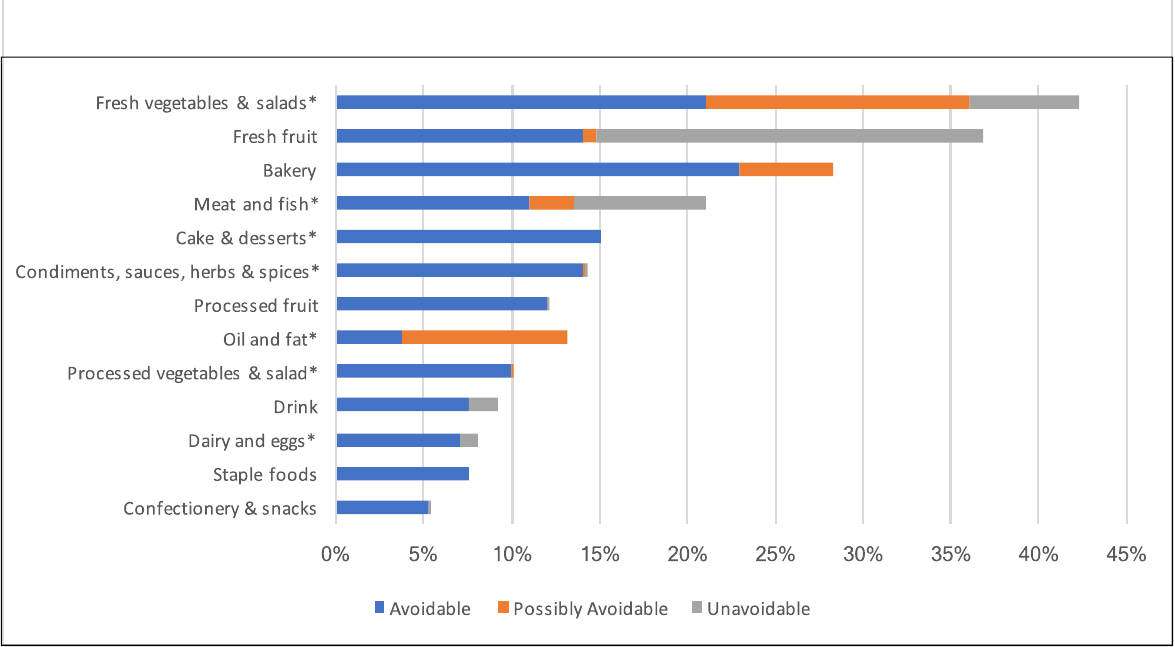
Figure 2. Food Loss and Waste (FLW) as a Percentage of Purchases, by Food